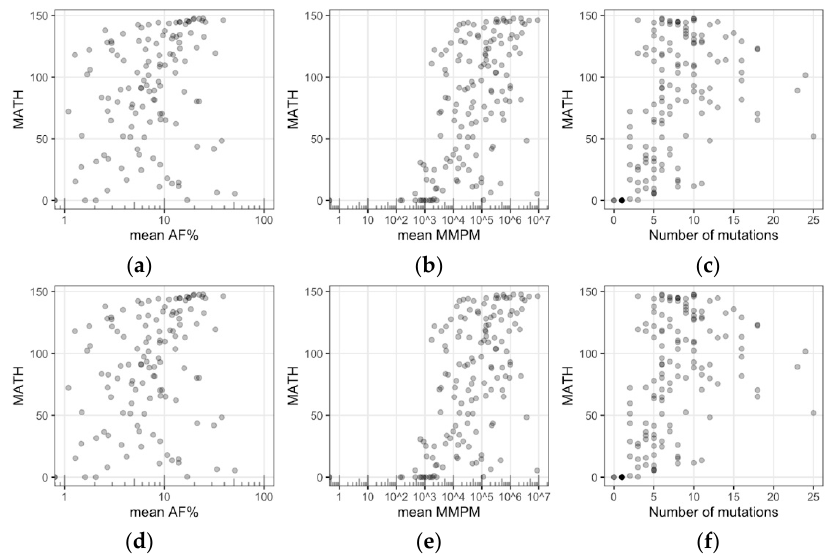
Figure A3. Correlation between MATH and mean AF or mean MMPM or number of somatic mutations. Correlation between pre-induction MATH and mean AF ( a ) Spearman rho = 0.542), mean MMPM; ( b ) Spearman rho = 0.595), or number of somatic mutations; ( c ) Spearman rho = 0.536). Correlation between post-induction MATH and mean AF; ( d ) Spearman rho = 0.493), mean MMPM; ( e ) Spearman rho = 0.489), or number of somatic mutations; ( f ) Spearman rho = 0.809).